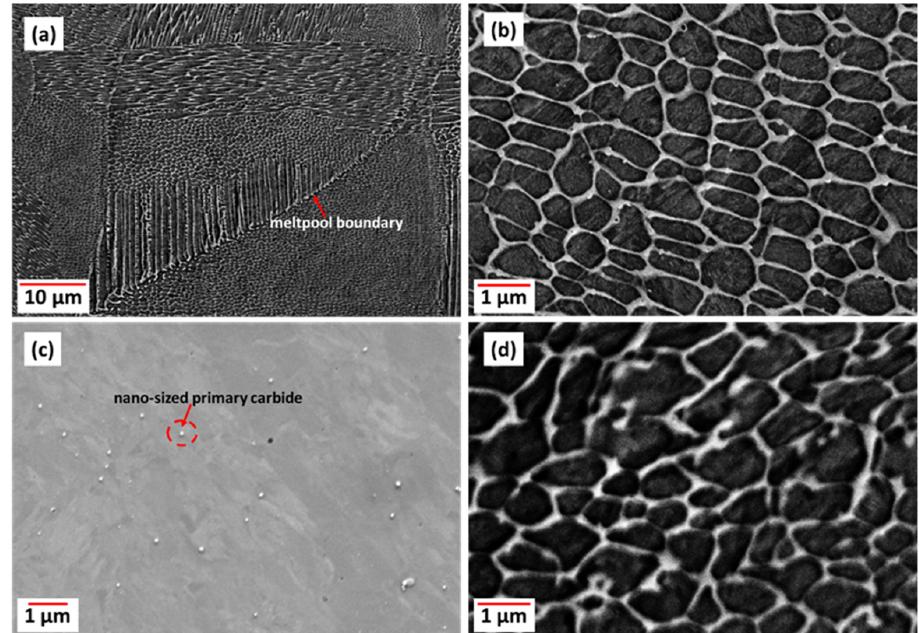
Figure 4. The SEM micrographs of the modified 1.2343 as-built 30 µm layer thickness and ( a ) cell structure in different orientations. ( b ) Cell structure at higher magnification. Preheated at 500 °C ( c ) with primary carbides. ( d ) Cell structure at higher magnification.